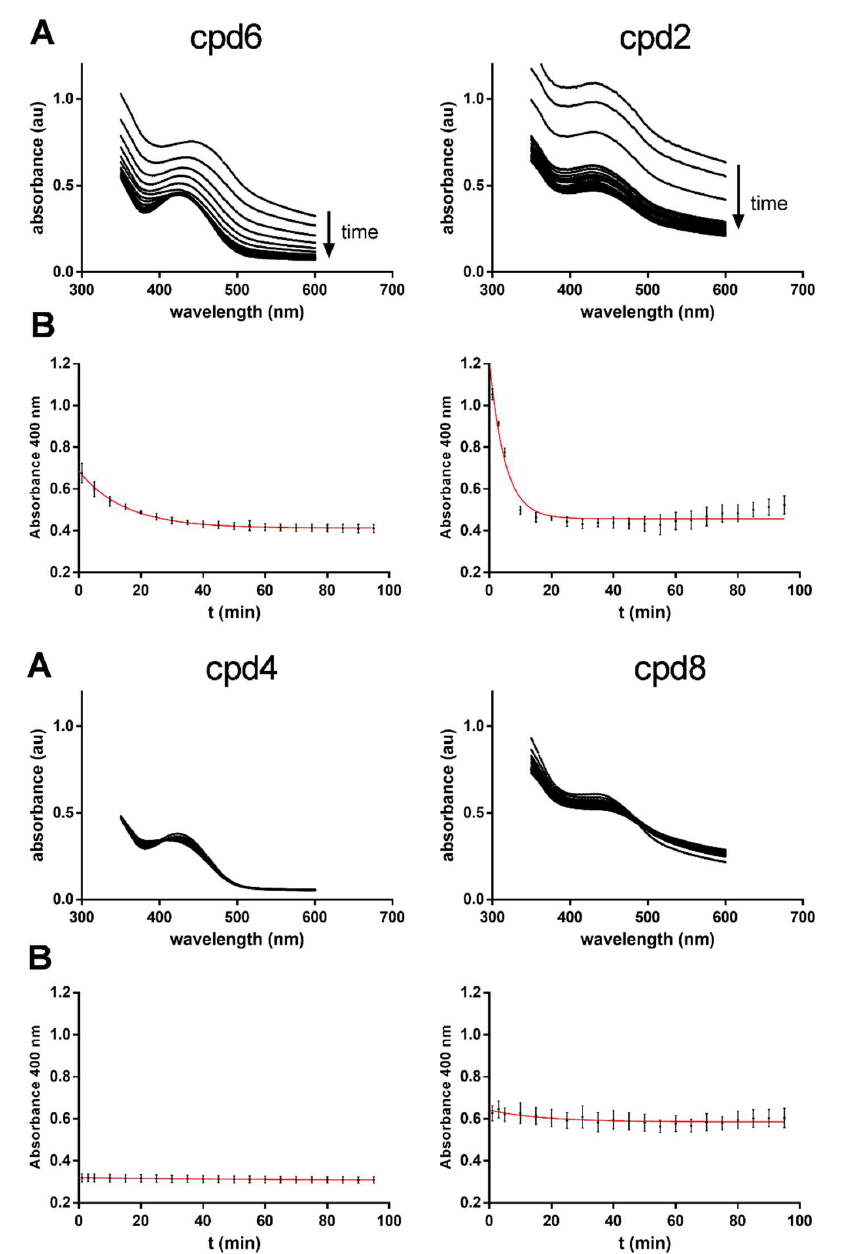
Figure 9. Kinetic analysis of the ester hydrolysis by rhodesain. A ) Time-dependent measurement of absorbance spectra (λ = 350-600 nm) of the respective compounds treated with rhodesain; B ) Plot of absorbance at 400 nm versus time showed hyperbolic turnover curves for the methyl ester (cpd. 6 , t 1/2 = 10.2 min) and the benzyl ester (cpd. 2 , t 1/2 = 3.41 min) but not for the free acid (cpd. 4 ) and the tert - butyl ester (cpd. 8